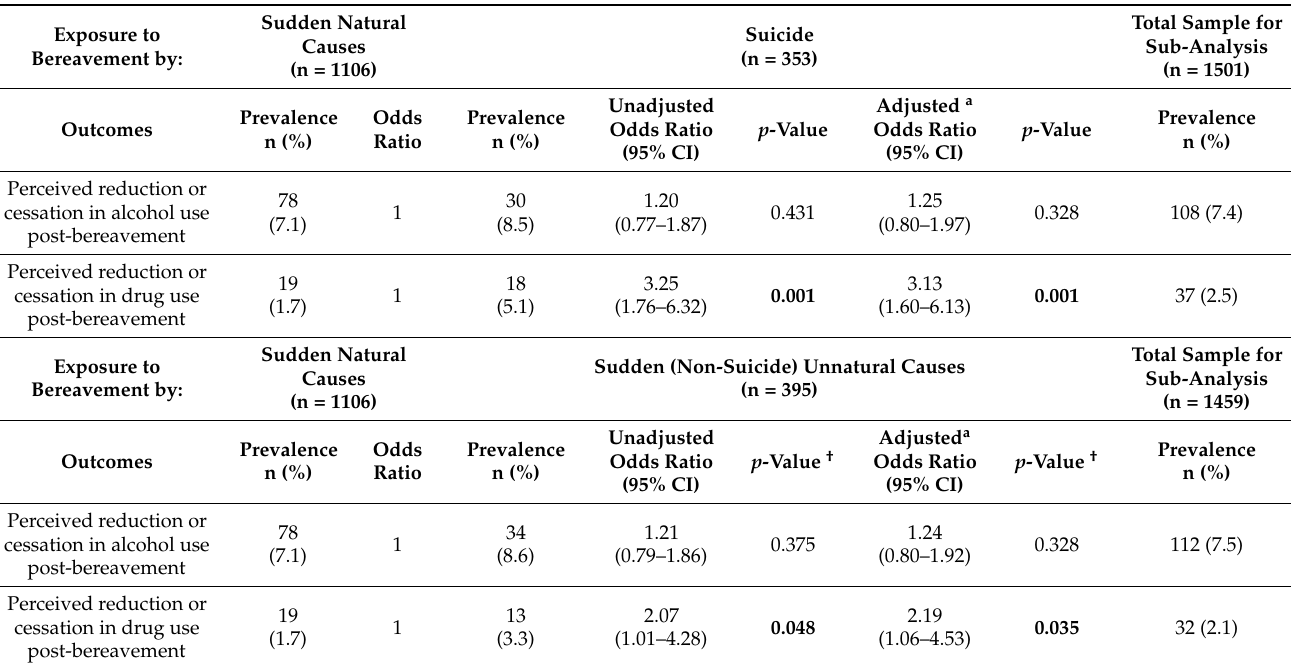
Table 3. Sensitivity analyses showing the associations between bereavement exposure sub-type and perceived reduction/cessation in substance